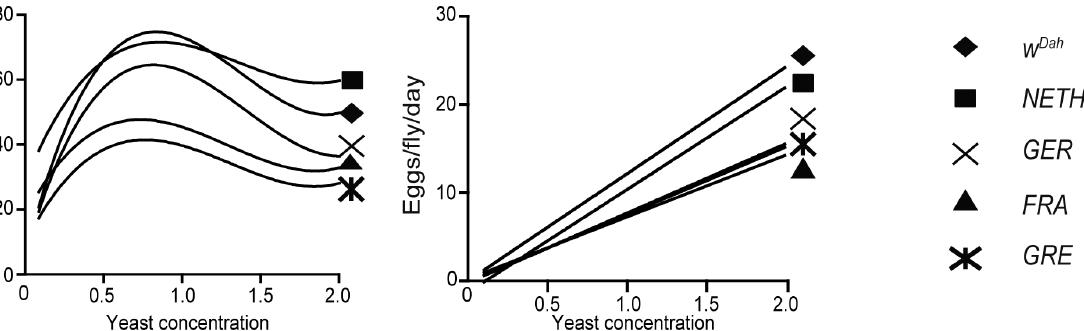
Figure 3. Norms of reaction of wild-derived Drosophila populations. Lifespan and fecundity showed different shapes of response to yeast concentration. The effect of yeast concentration on lifespan best fitted a third-order polynomial equation (non-linear regression) and on fecundity a linear equation (linear regression). Goodness of fit is high in both models, as represented by R 2 values: For mean lifespans: 0.88, 0.74, 0.80, 0.88, 0.79 for W Dah , FRA , GRE , GER , NETH strains respectively. For fecundity: 0.90, 0.87, 0.87, 0.89, 0.91 for W Dah , FRA , GRE , GER , NETH strains respectively. For mean lifespans, best-fit values ranged for B0: 6.6 to 28, for B1: 86.5 to 176, for B2: -81.6 to -151, for B3: 20.9 to 36.8. Linear regression analysis for fecundity: for W Dah : F=484.2, DFn=1, DFd=48, p , 1 6 10 2 4 , for FRA : F=335.7, DFn=1, DFd=48, p , 1 6 10 2 4 , for GRE : F=309.9, DFn=1, DFd=48, p , 1 6 10 2 4 , for GER : F=373.6, DFn=1, DFd=48, p , 1 6 10 2 4 , for NETH : F=508.2, DFn=1, DFd=48, p , 1 6 10 2 4 . Lifespan curves and fecundity slopes differed significantly among strains (for lifespan curves: F=63.23, DFn=16, DFd=230, p , 1 6 10 2 4 , for fecundity slopes: F=27.10, DFn=4, DFd=240,